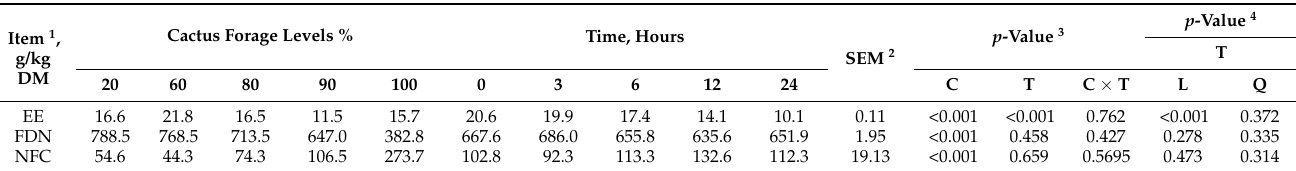
Table 4. Ether extract (EE), neutral detergent fiber (NDF), and non-fiber carbohydrates (NFCs) as a function of cactus forage and time of exposure to air as dry matter (DM).